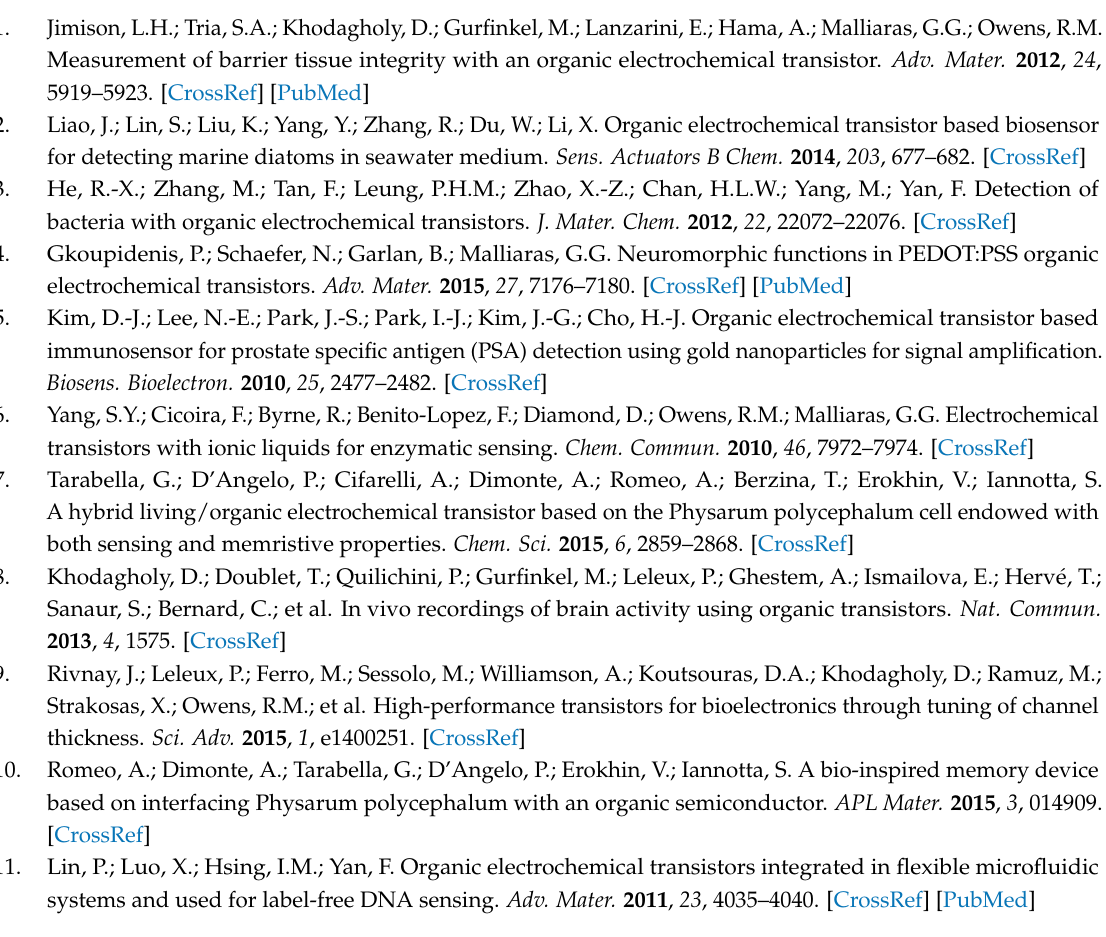
Figure S1: Typical transfer characteristics I gs versus V gs for the OECT with (A) 15 nm, (B) 70 nm, and (C) 130 nm thick channels. Transconductance curves g m versus V gs for (D) 15 nm, (E) 70 nm, and (F) 130 nm thick channels, Figure S2: (A) Transconductance peak g m * versus thickness at V ds = 0.4 V for films processed by an RTA post-processing procedure; (B) effect of the post-processing conditions on the current modulation parameter ∆ I / I 0 , reported as a function of PEDOT:PSS thickness, for films processed by RTA (black squares) and LTA (red circles) post-processing procedures (orange and blue dotted lines are guides for the eye), Figure S3: (A) Typical modulation step (black curve) recorded at V ds = − 0.1 V, V gs = − 0.4 V, and a double exponential decay fit curve (red curve); (B) device response time τ res versus V gs for different device channel thicknesses at V gs = 0.05, 0.1, and 0.4 V; τ res versus channel thickness for (C) V gs = 0.2 V and (D) V gs = 0.4 V. References [9,60] are cited in the Supplementary